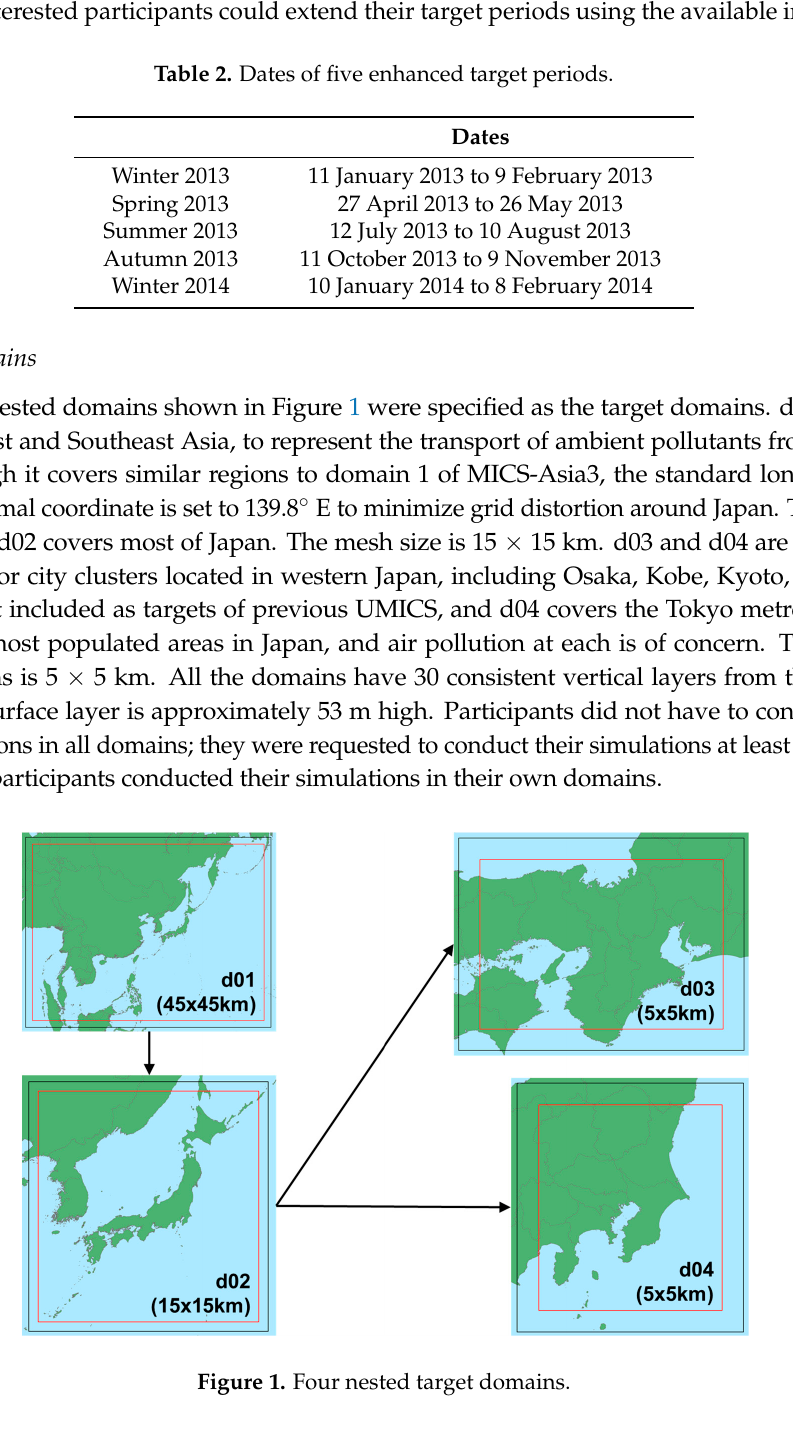
Table 2. Dates of five enhanced target periods.